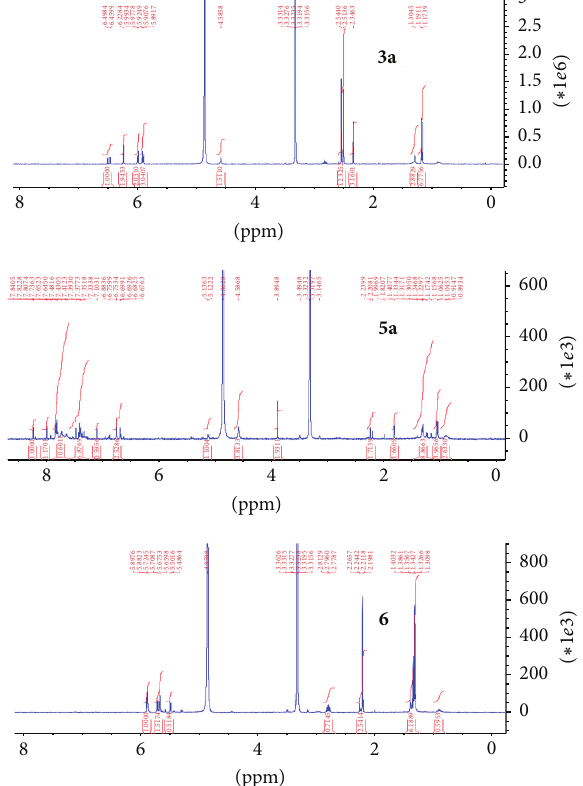
Figure 2: The experimental proton NMR of the complexes 3a , 5a, and 6 derivatives obtained in the CD 3 OD